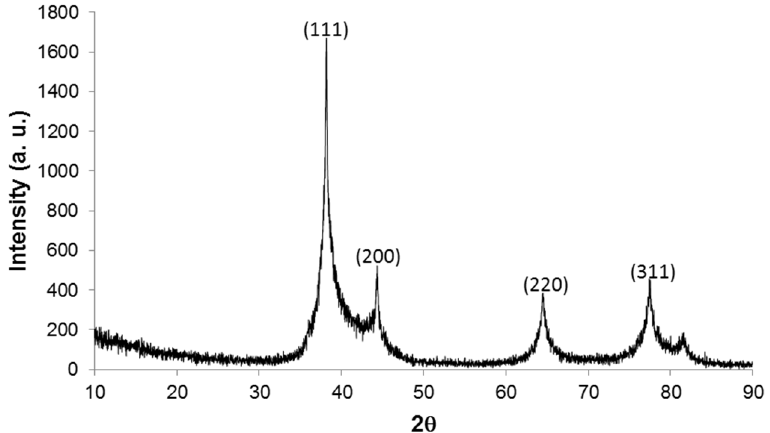
Figure 2. X-ray powder diffraction (XRD) patterns of the DNA/Ag